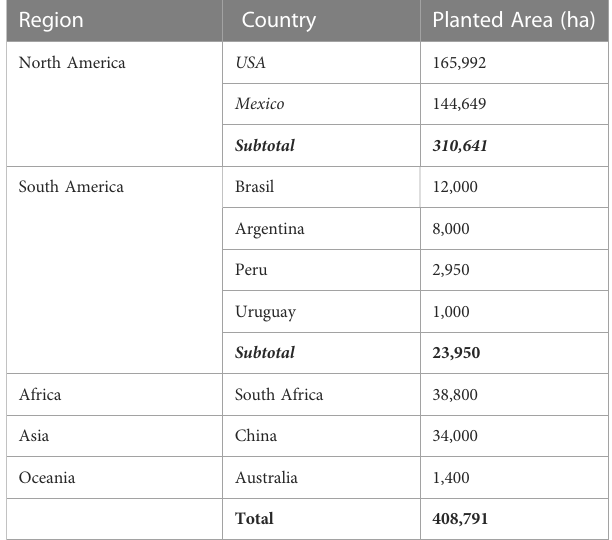
TABLE 2 Pecan planted area by region and